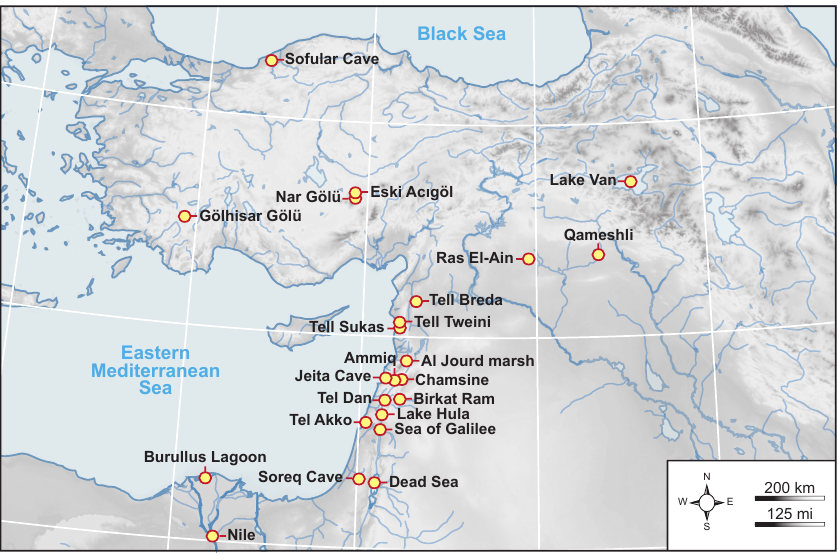
Figure 1. Geographical location of some of the main Levantine sites discussed in this study. Nearby sites in Turkey and Egypt are also displayed on the map (see the text for full